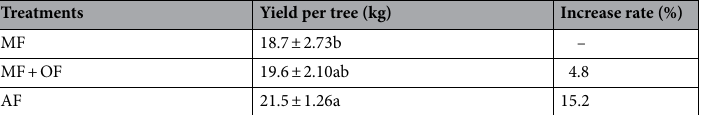
Table 2. Effects of fertilizer treatments on yield per tree of kiwifruit. The different letters after the values indicated the significant differences (P < 0.05) of kiwifruit yields between the treatments. The standard errors (n = 3) are